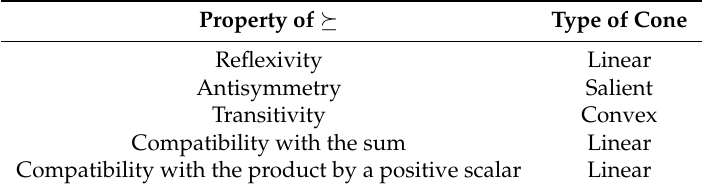
and types of cones. Source: Own elaboration. Table 1. Possible properties of (cid:23) Property of Type of Cone (cid:23) Reflexivity Linear Antisymmetry Salient Transitivity Convex Compatibility with the sum Linear Compatibility with the product by a positive scalar Linear